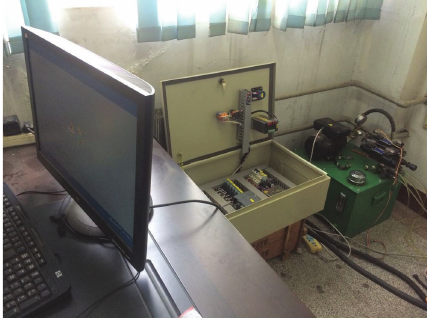
Figure 7: The experimental equipment.